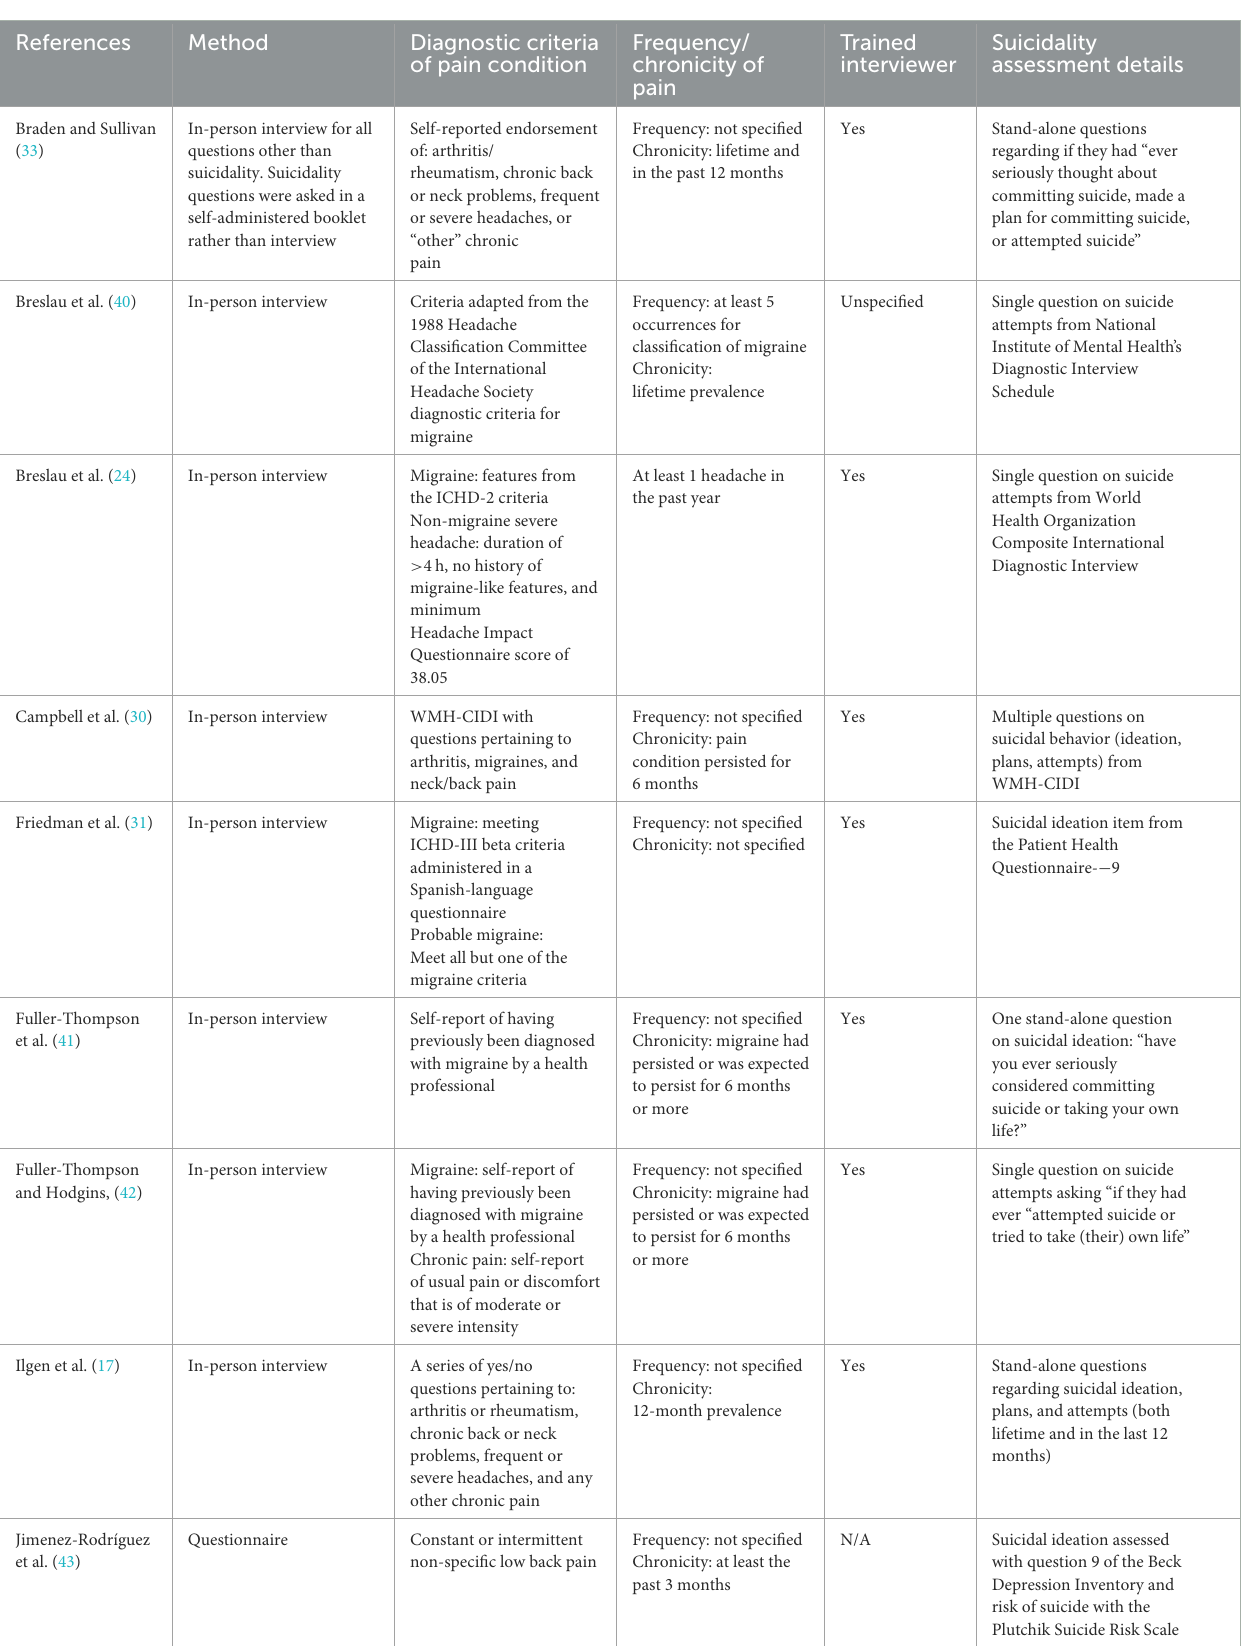
TABLE 1 Clinical features assessed in meta-analysis